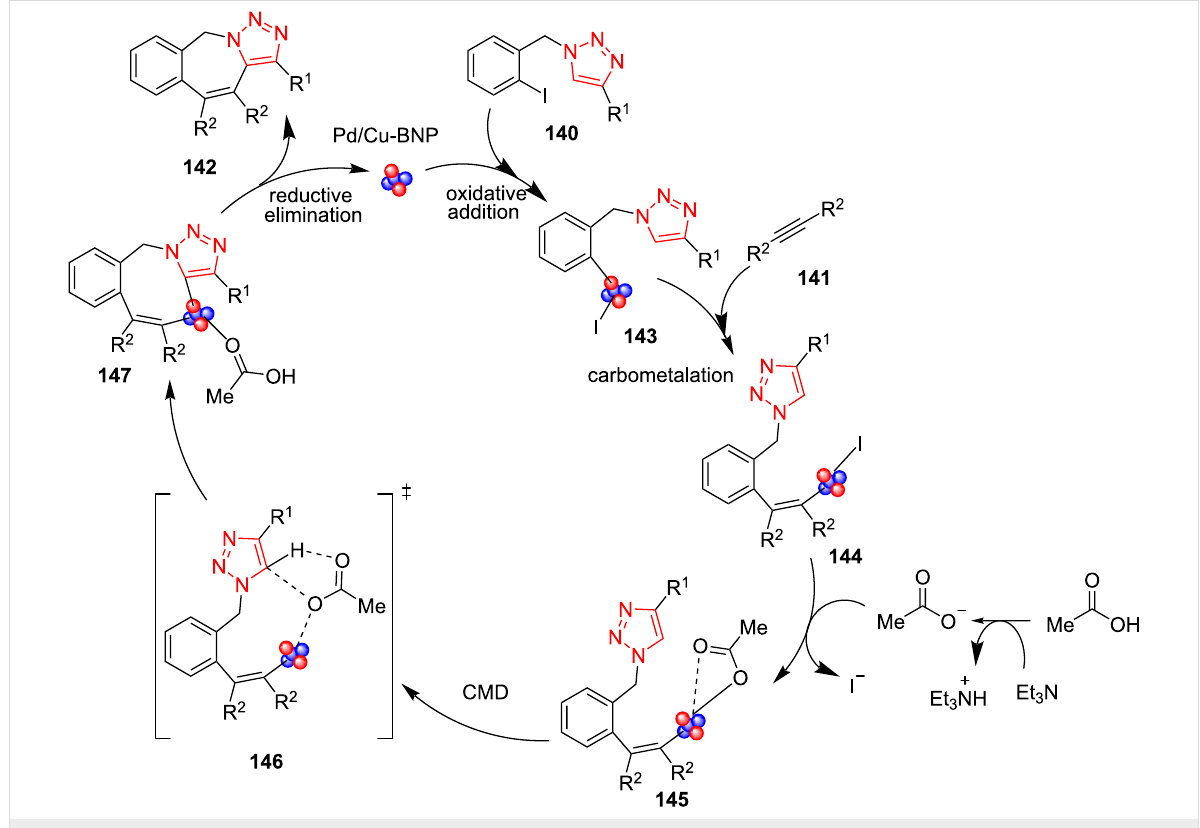
Scheme 41: A probable mechanism for the synthesis of polycyclic triazoles 142